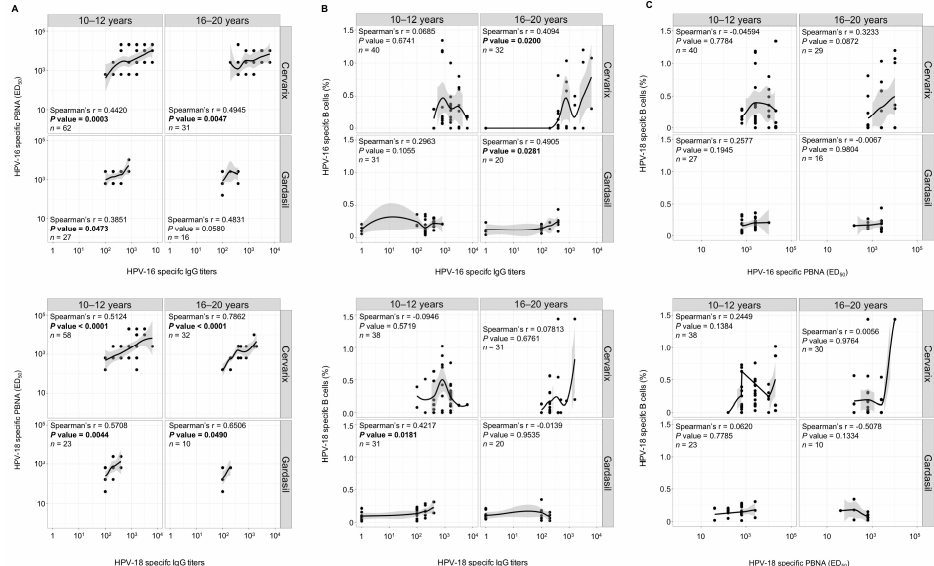
Figure 6. Correlation between HPV-16 and HPV-18 specific IgG, nAbs and memory B cells. Correlation between ( A ) IgG and nAbs, ( B ) IgG and memory B cells and ( C ) nAbs and memory B cells. In each panel, data are stratified by age group (horizontal squares), type of vaccine (top-bottom squares) and HPV subtype (HPV-16, A, B, C, upper panels; HPV-18, A, B, C, bottom panels). Regression lines (dark, full lines) and 95% confidence interval (grey areas) are shown. Spearman’s rank correlation determined statistical significance.